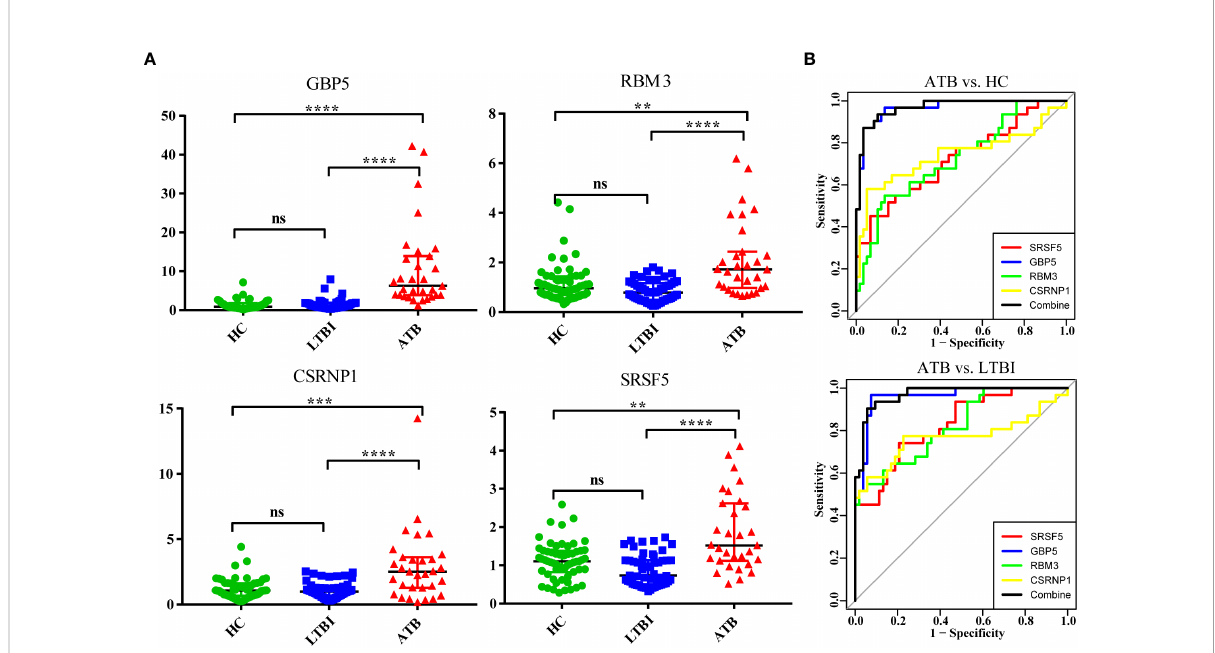
FIGURE 7 Validation of four signi fi cantly differentially expressed genes in an independent cohort by qPCR. (A) The scatter plot shows the relative expression of each gene in all samples. (B) The ROC curve used ATB as the case group, and LTBI and HC as the control group, respectively. ns (not signi fi cant) P > 0.1234, *P < 0.0332, **P < 0.0021, ***P < 0.0002, and ****P <